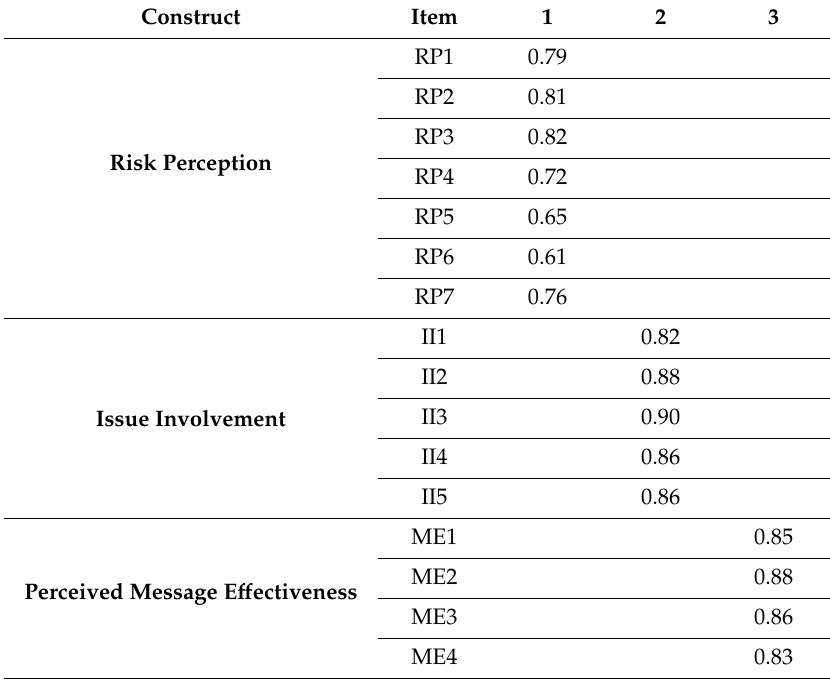
Table 3. Results of principal component factor analysis.